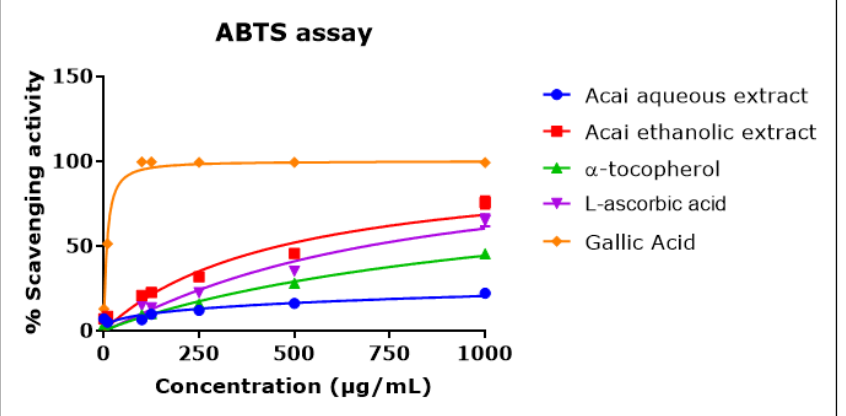
Figure 3. ABTS •+ scavenging activity of acai aqueous and ethanolic extracts. Acai antioxidant activ-